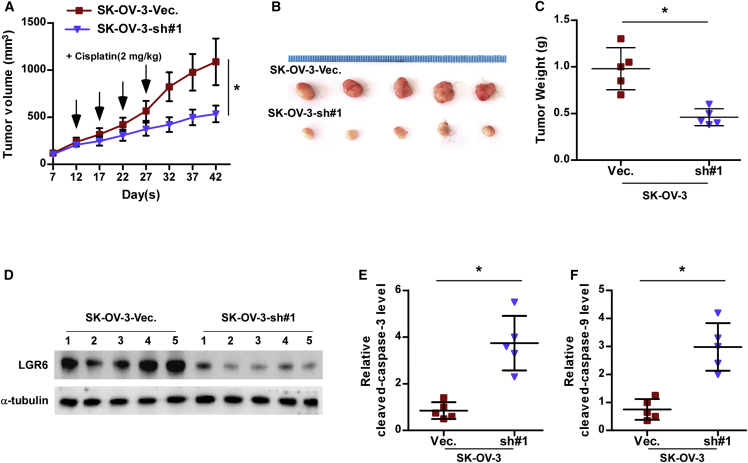
Silencing LGR6 Improves Chemoresistance of Ovarian Cancer Cells to Cisplatin In Vivo(A) Tumor volumes were measured every 5 days in the indicated mice groups. Each bar represents the median values ± quartile values. (B) Images of excised tumors from the BALB/c mice on day 42 after injection with the indicated cells. (C) Average weight of excised tumors from the indicated mice. Each bar represents the median values ± quartile values. *p < 0.05. (D) Western blotting analysis of LGR6 in the indicated tumor tissues. α-tubulin served as the loading control. (E and F) Analysis of the activities of caspase-3 (E) and caspase-9 (F) in the indicated tumor tissues. Each bar represents the median values ± quartile values. *p < 0.05.